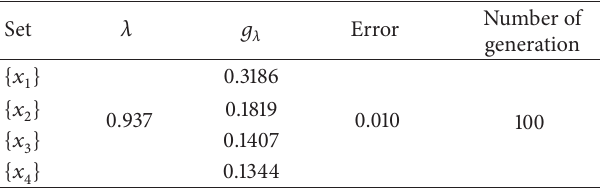
Table 8: Results of Example